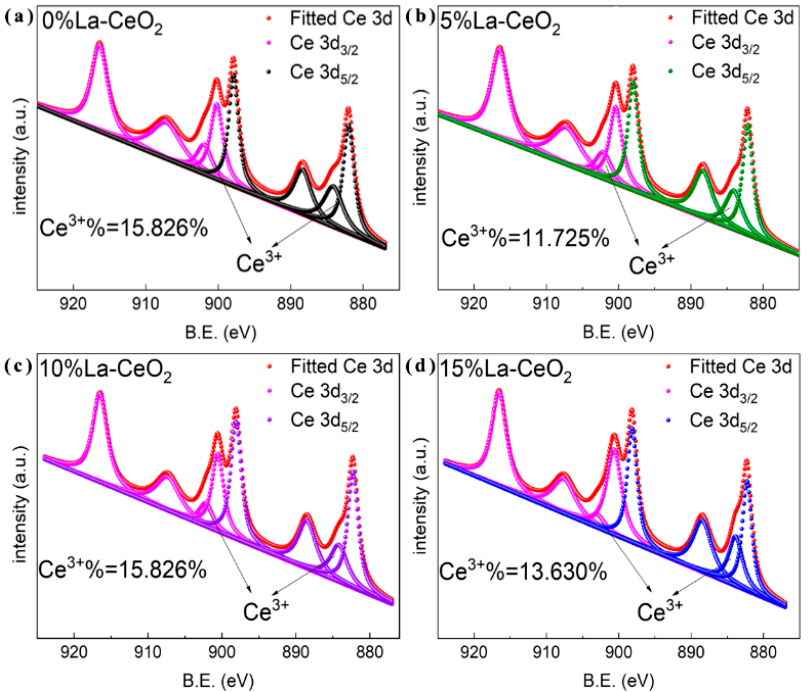
Figure 3. XPS of cerium in cerium oxide doped with lanthanum at different concentrations: ( a ) 0% La-CeO 2 , ( b ) 5% La-CeO 2 , ( c ) 10% La-CeO 2 and ( d ) 15% La-CeO 2 .